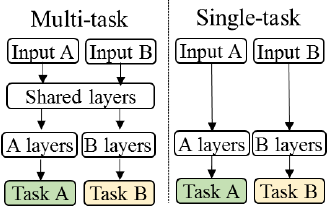
Figure 1. Multi-task learning vs. single-task